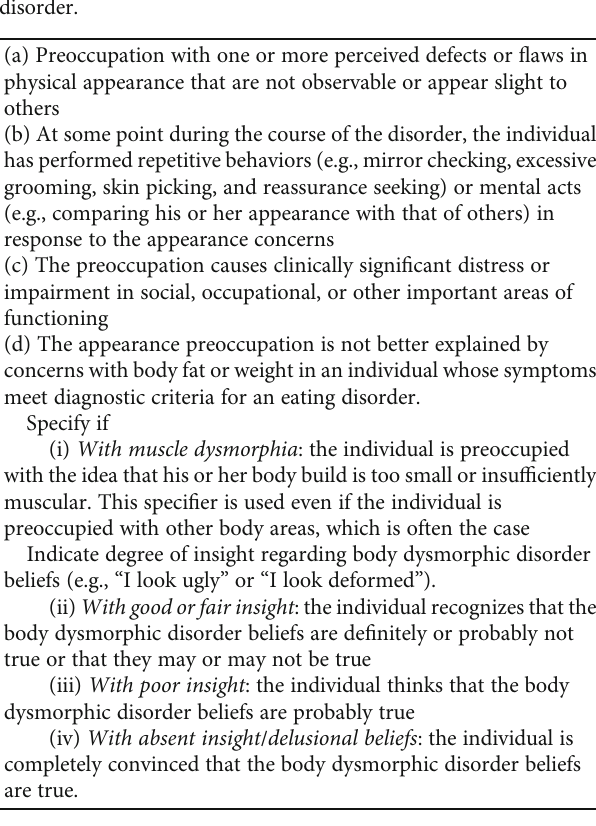
Table 2: Screening questions for